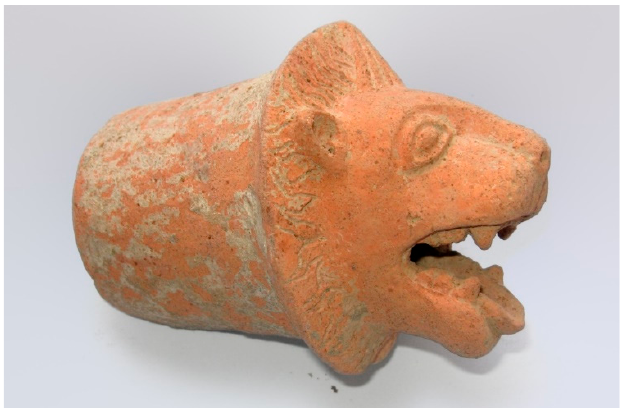
Figure 20. Lion-headed waterspout (gargoyle) (MGW inv. no. 3123); terracotta; [n.d.].